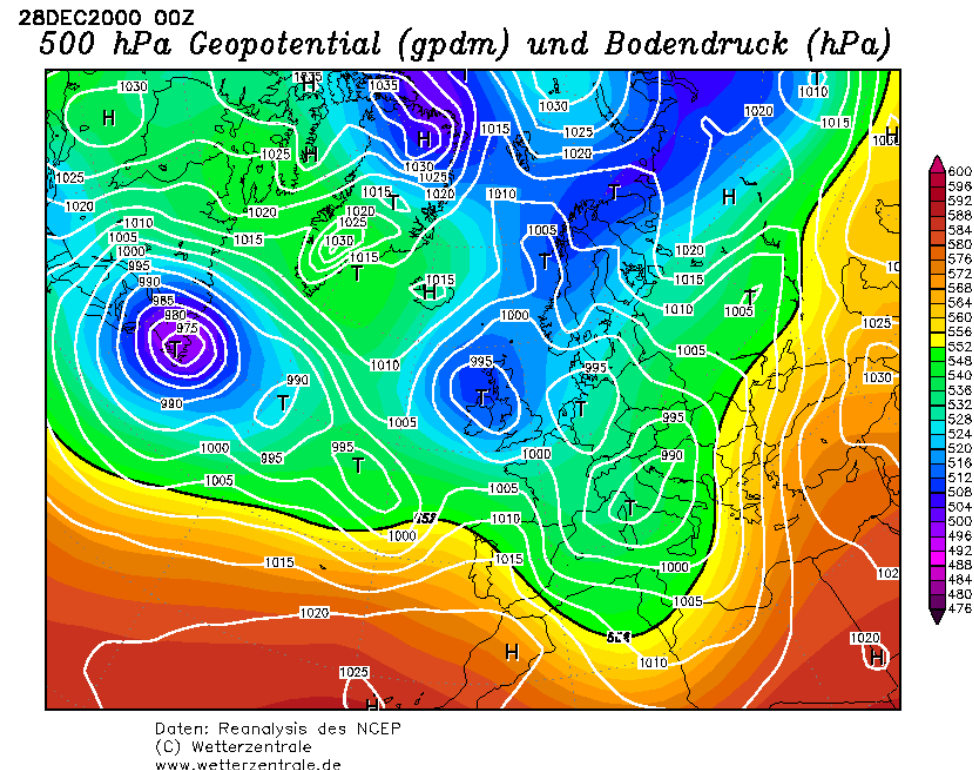
Fig. 10. Composite map of sea level pressure (hPa) and 500 hPa geopotential fields for the North Atlantic Ocean and Europe, December 28, 2000 (http://www.wetterzentrale.de/).